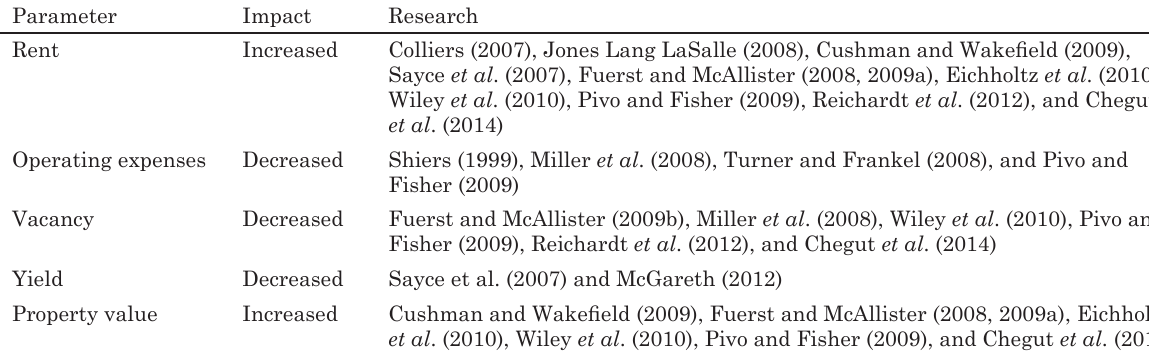
Table 1. Summary of the literature